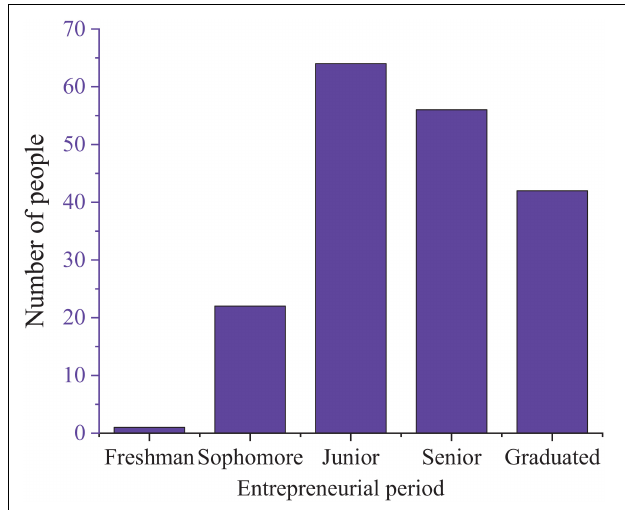
FIGURE 4 | Entrepreneurial time choice of college students.